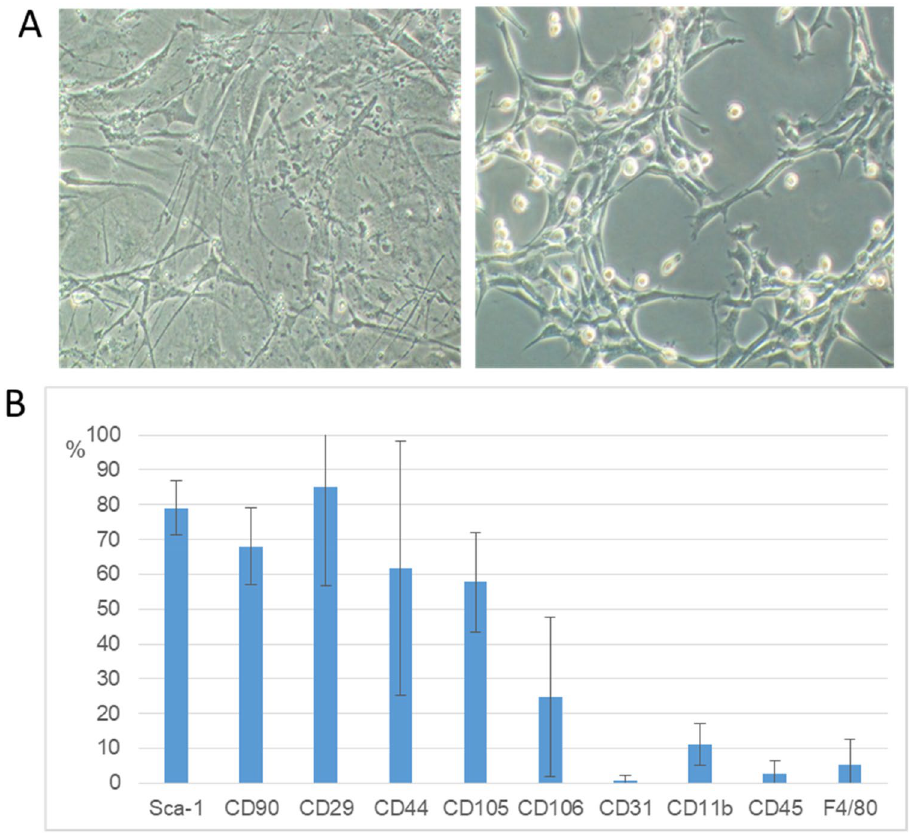
Figure 1. The morphology ( A ) and phenotype ( B ) of the isolated cells. Microscopic observations of the cell culture (lens magn. 5 × left, 10 × right) ( A ). Antigen profile of the isolated cells: presence of Sca-1, CD29 (approx. 80%), CD90 (approx. 70%), CD44, CD105 (approx. 60%) antigens, a small percentage of CD106 (approx. 20%) and CD11b (10%), absence of F4/80 (approx. 4%) and CD45, CD31 antigens (below 3%), (n = 5) ( B ).